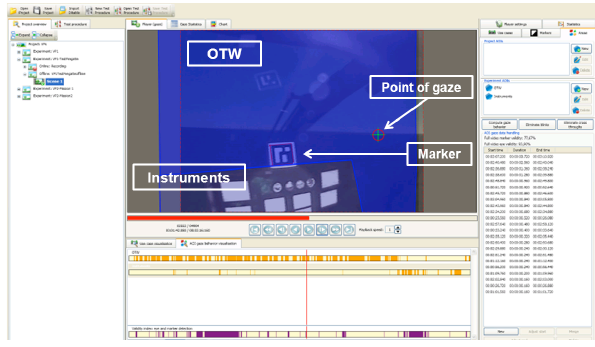
Figure 3. Position of AOIs “OTW” and “Instruments” (Software D-Lab® from Eye Tracking System Dikablis®).